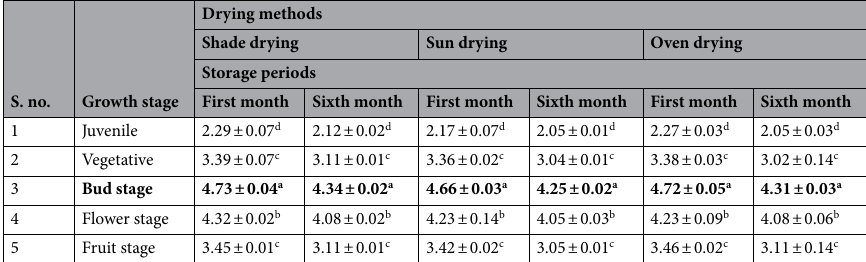
Table 1. Effects of drying method and time of harvest (season and growth stage) on mangiferin yield from different storage periods of Swertia chirata L. Bold value indicate best results.